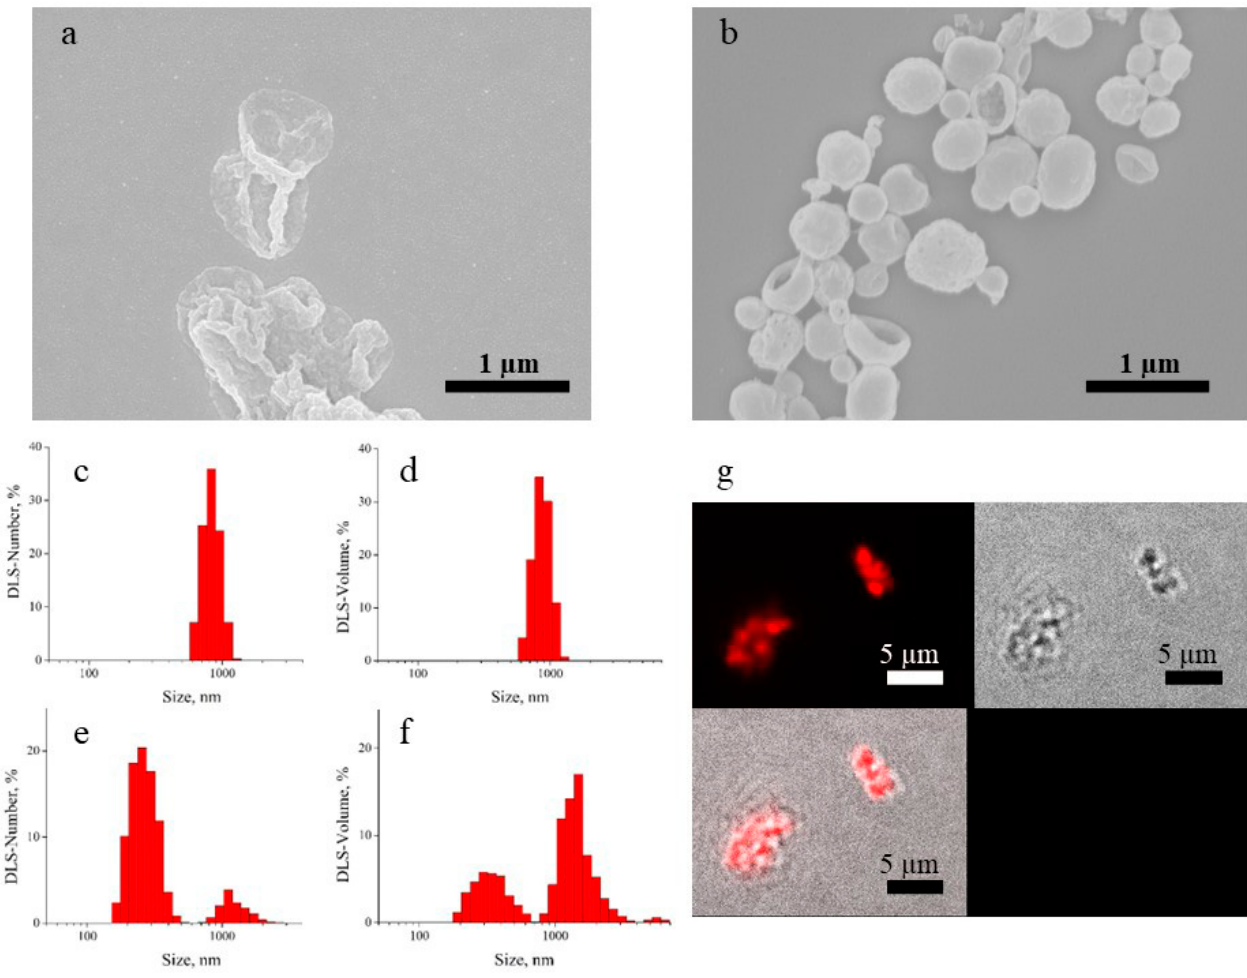
Figure 1. SEM images of the intact ( a ) and heat treated ( b ) (Parg/DS) 3 capsules; DLS of the capsule samples: DLS-Number ( c ) and DLS-Volume ( d ) distributions for the intact capsules, DLS-Number ( e ) and DLS-Volume ( f ) distributions for heat treated capsules; CLSM images of the Rhodamine 6G-loaded intact (Parg/DS) 3 capsules in fluorescent and transmission channels with their overlay ( g ).